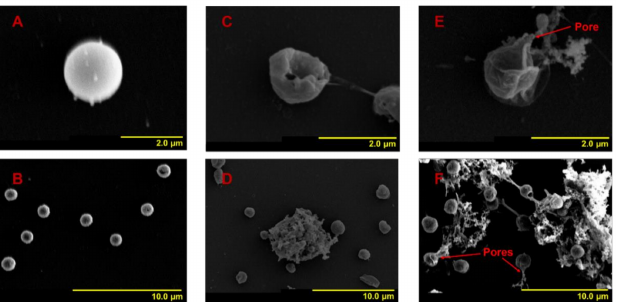
Figure 2. Changes in cell shape features of residual A. anophagefferens (CCMP 1984) after treatment with NC or MC for 24 h. ( A , B ) Normal cells (group 1); ( C , D ) residual cells treated with NC (group 2); ( E , F ) residual cells treated with MC (group